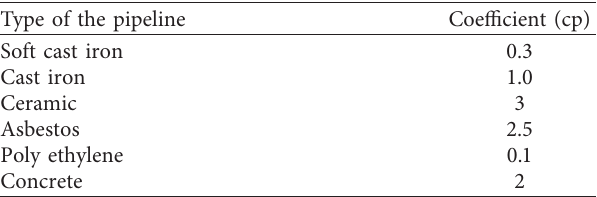
Table 4: Weighted coefficient for type of pipe.